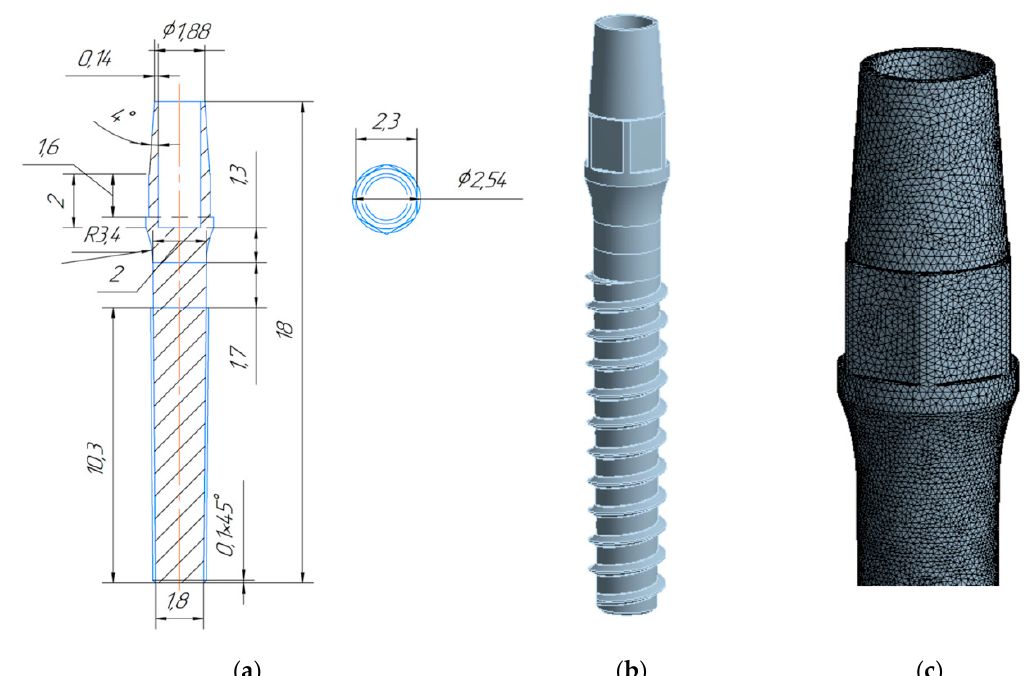
Figure 7. Geometry of the dental nanoimplant: ( a ) technical drawing with dimensions in mm; ( b ) 3D model; ( c ) enlarged FEM mesh.